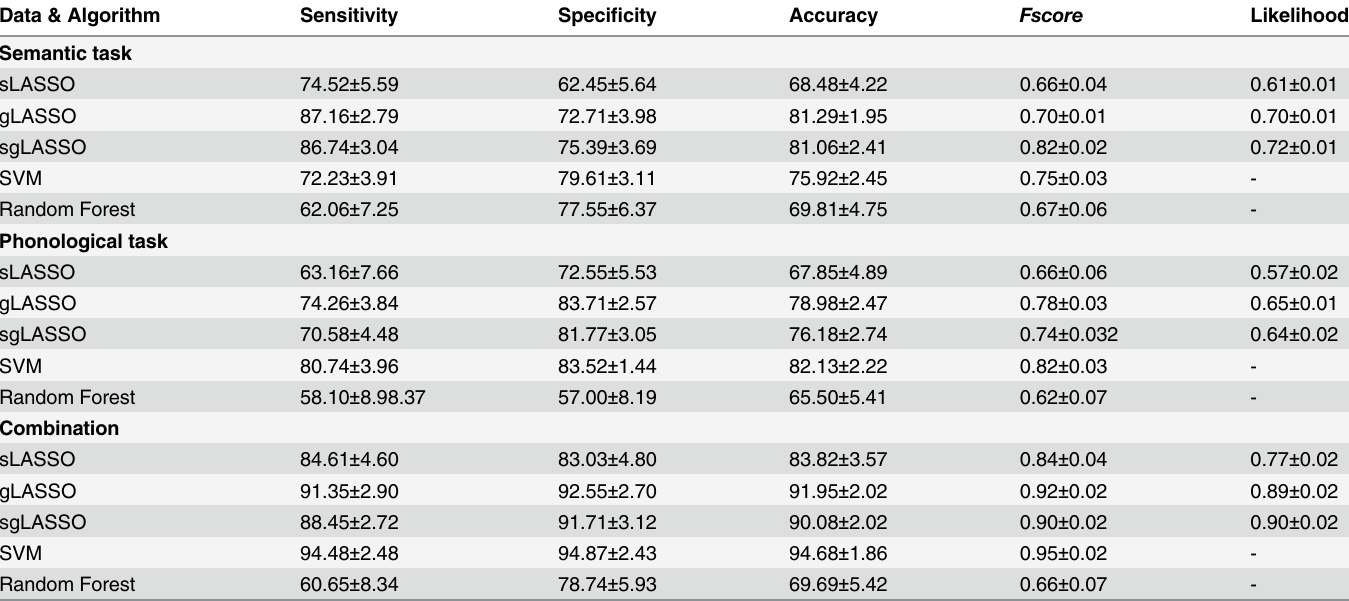
Table 2. Classification Performance (mean ± std over 100 10-fold